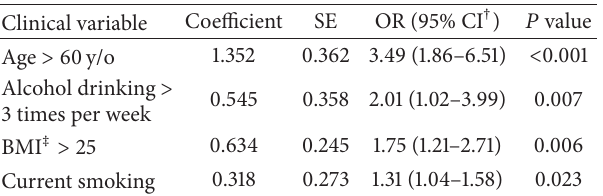
Table 5: Independent risk factors for the development of colorectal adenomatous